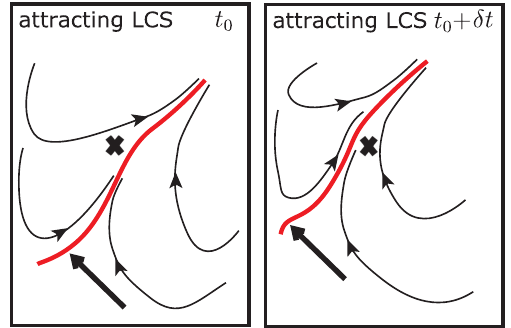
Figure 11. An attracting LCS feature (red) passes over the geo- graphically fixed sampling location (indicated by a bold × ). Black lines show trajectories of hypothetical particles that are absorbed to a moving attracting LCS. The bold arrow shows the general wind direction and the motion of the attracting LCS at the specified inter- val. Collected samples on either side of this attracting LCS feature come from two different regions. Figure 12. Three calculated trajectories of (hypothetical) collected